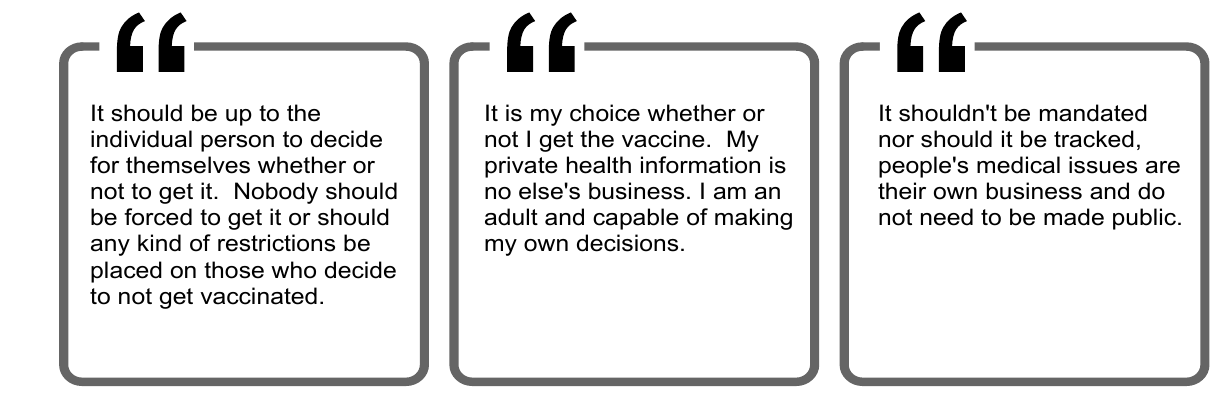
Figure 11. Participant perspectives regarding autonomy to decide about vaccination.